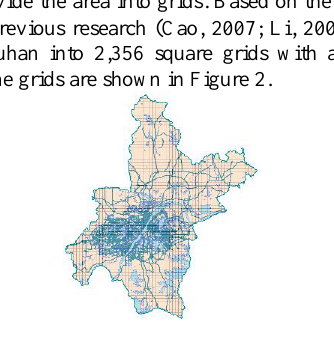
Figure 2. The divided square grids of Wuhan City,